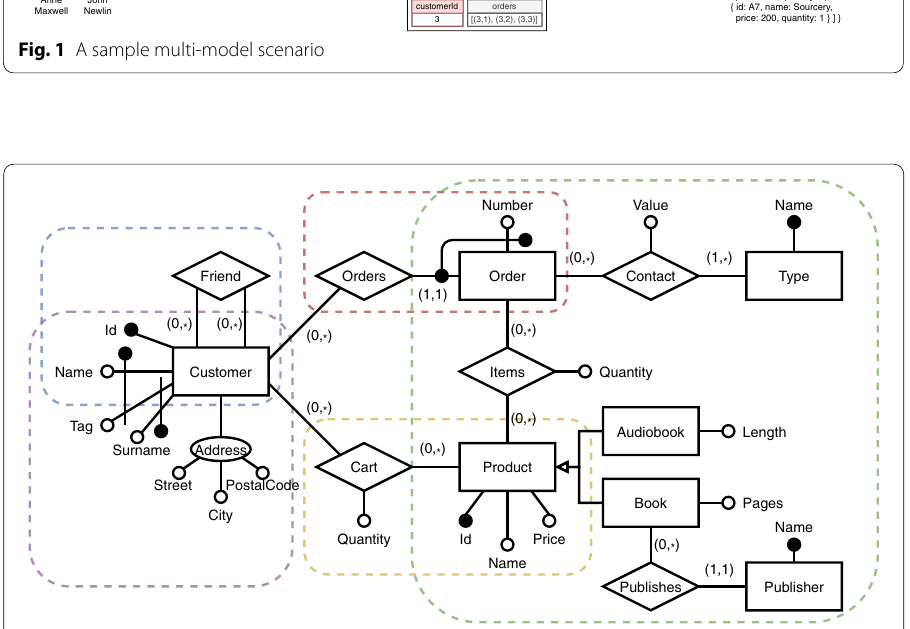
Fig. 2 ER schema of the sample multi-model scenario in Fig.